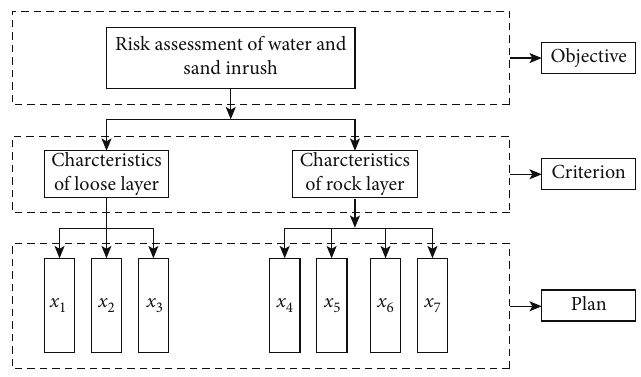
Figure 3: Hierarchical structure system of water and sand inrush index for mining under loose layers. Table 1: Risk grade interval of water and sand inrush risk assessment